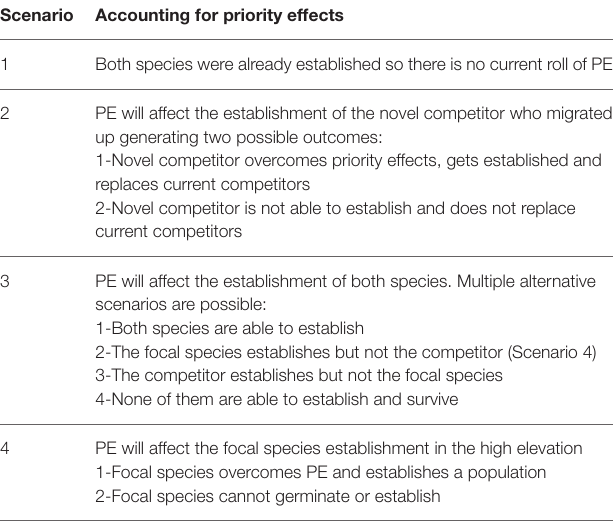
TABLE 1 | The 4 scenarios proposed by Alexander et al. (2015) and some possible outcomes if priority effects are incorporated. Scenario Accounting for priority